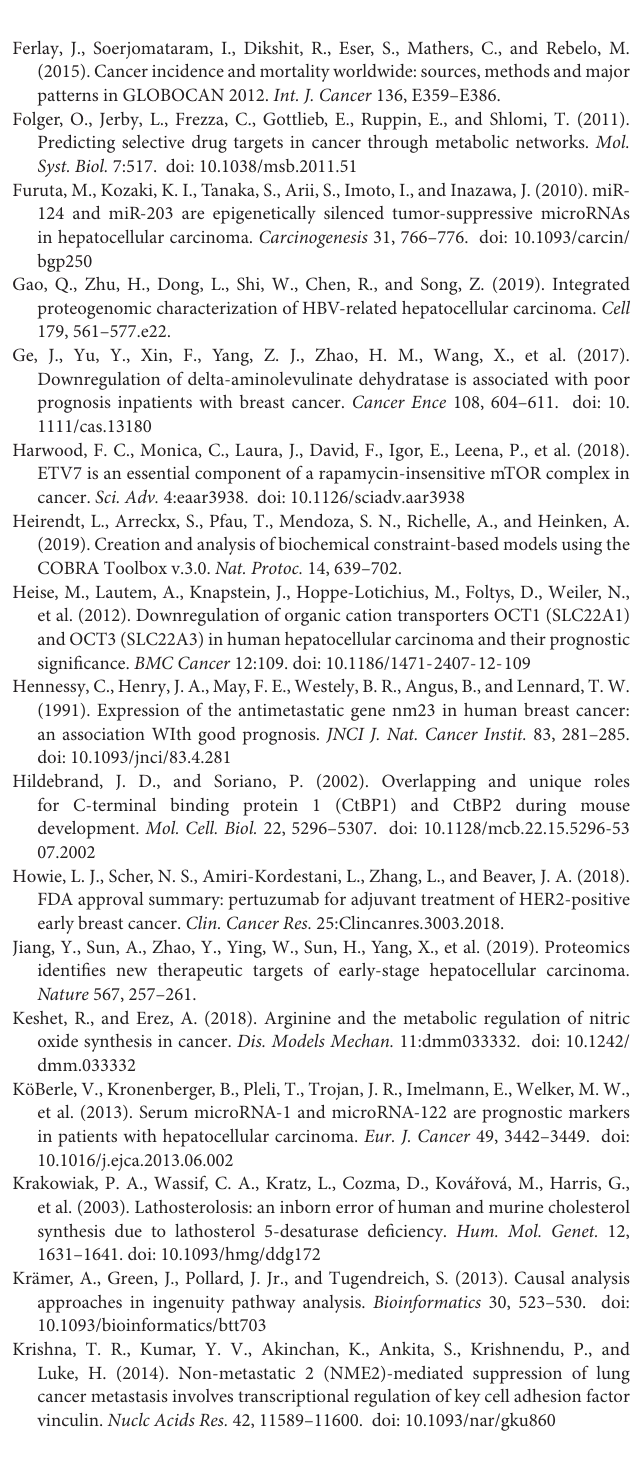
Supplementary Table 3 | Differentially expressed genes in Class2 compared to Class 1 and Class 3 in TCGA-LIHC samples. Supplementary Table 4 | Altered metabolic reactions in Class2 compared to Class 1 and Class 3 in TCGA-LIHC samples. Supplementary Table 5 | 28 core genes filtered according to our